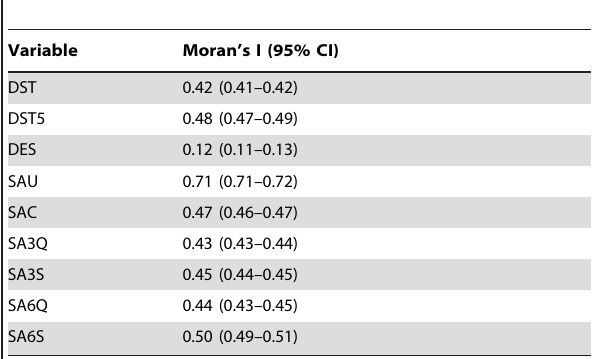
and Moran’s I = 0.48 in DST5), while service density has a low spatial autocorrelation (Moran’s I = 0.12). Unweighted 2SFCA Table 5. Global Moran’s I of nine GIS-based measures in access to mammography in St. Louis.